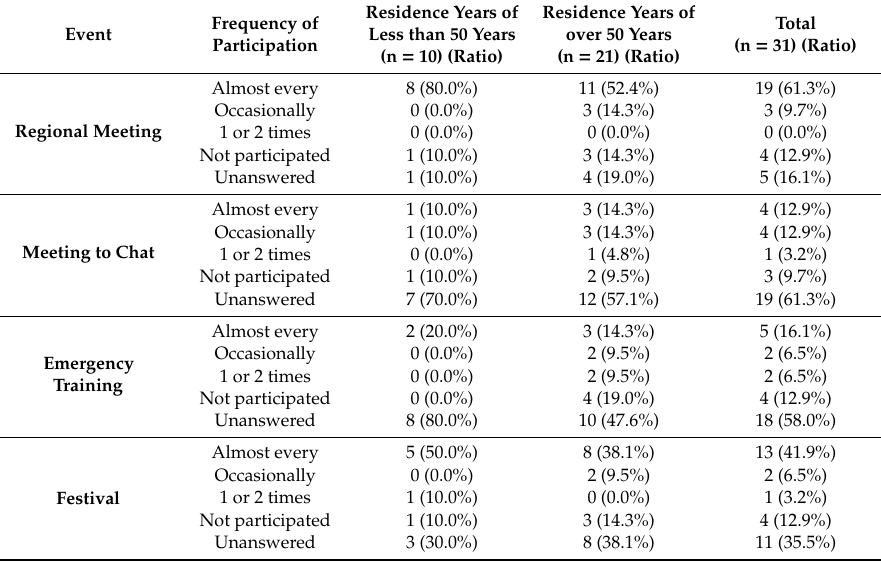
Table A2. Participation situation of events / gatherings (n = 31).